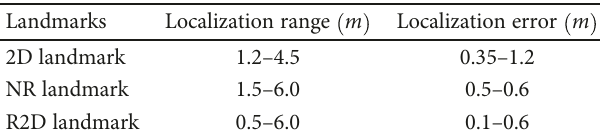
Table 1: Landmark comparison experiment results (landmark size is 0.7